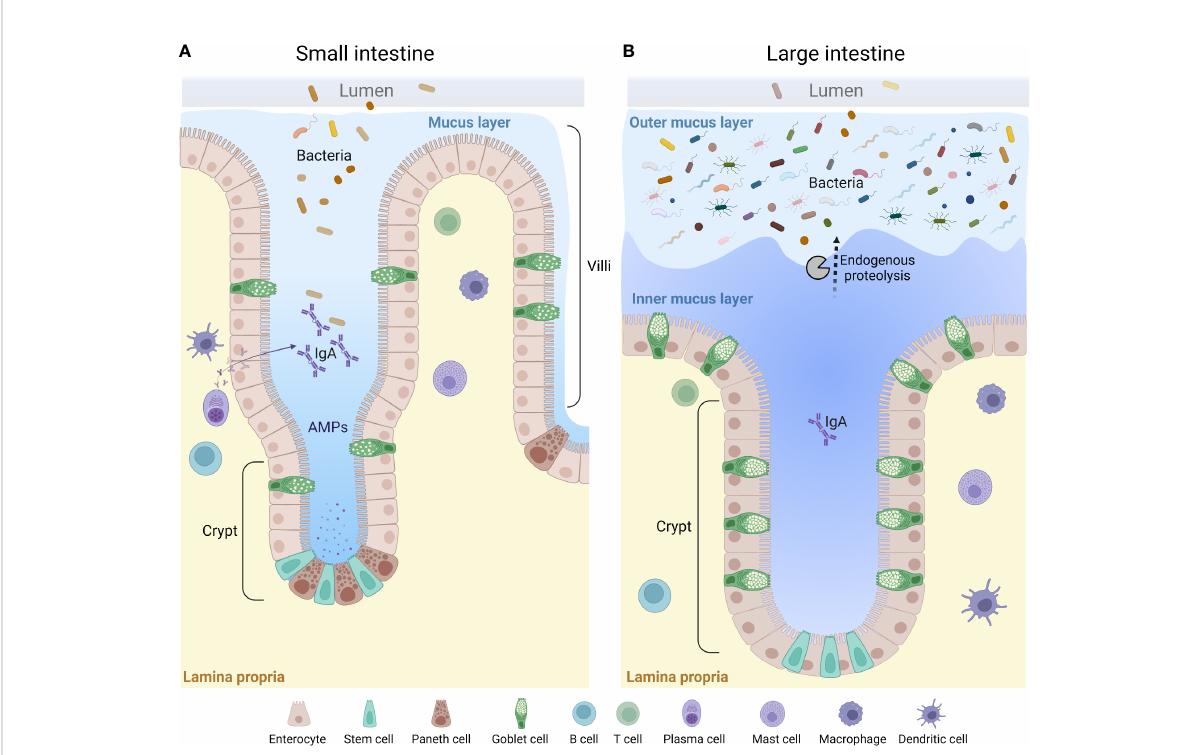
FIGURE 2 A general overview of the mucus layer in the small and large intestine. The mucus layer is a key component of the intestinal barrier. It is mainly composed of mucin glycoproteins produced and secreted by the intestinal goblet cells. The small intestine is characterized by a loose and unattached mucus layer containing antimicrobial products that limit penetration by bacteria (A) , whereas the large intestine presents a dense and fi rmly attached mucus layer converted to a looser structure at the luminal side via endogenous proteolysis (B) . AMPs, anti-microbial